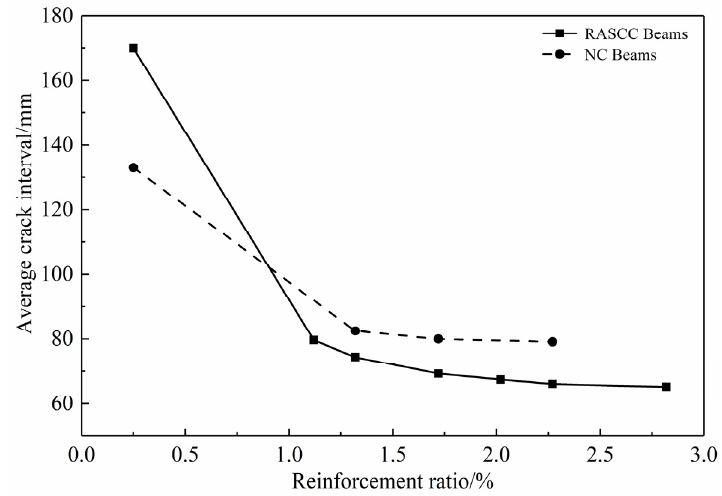
Figure 8. Comparison of average crack interval between NC and RASCC beams.